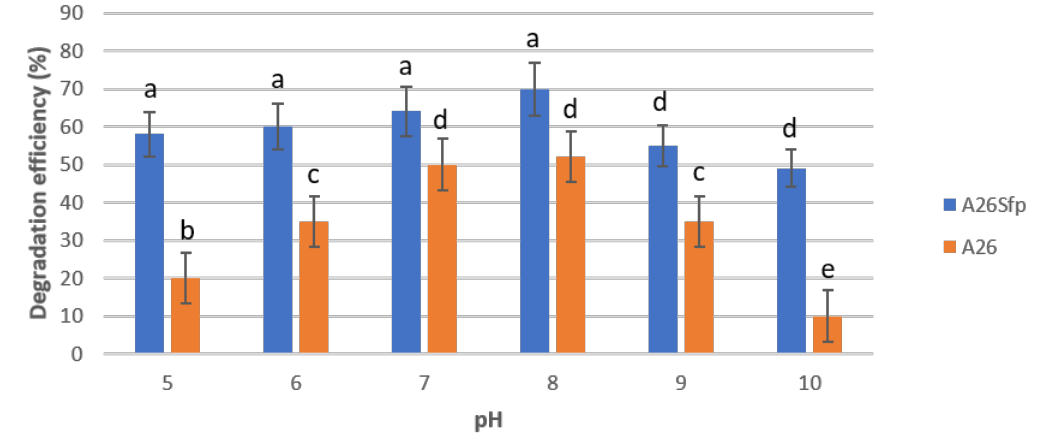
Figure 4. Effect of pH on biodegradation of naphthalene by Paenibacillus polymyxa A26 and P. polymyxa A26Sfp. Different letters indicate statistically significant differences; see Material and Methods.